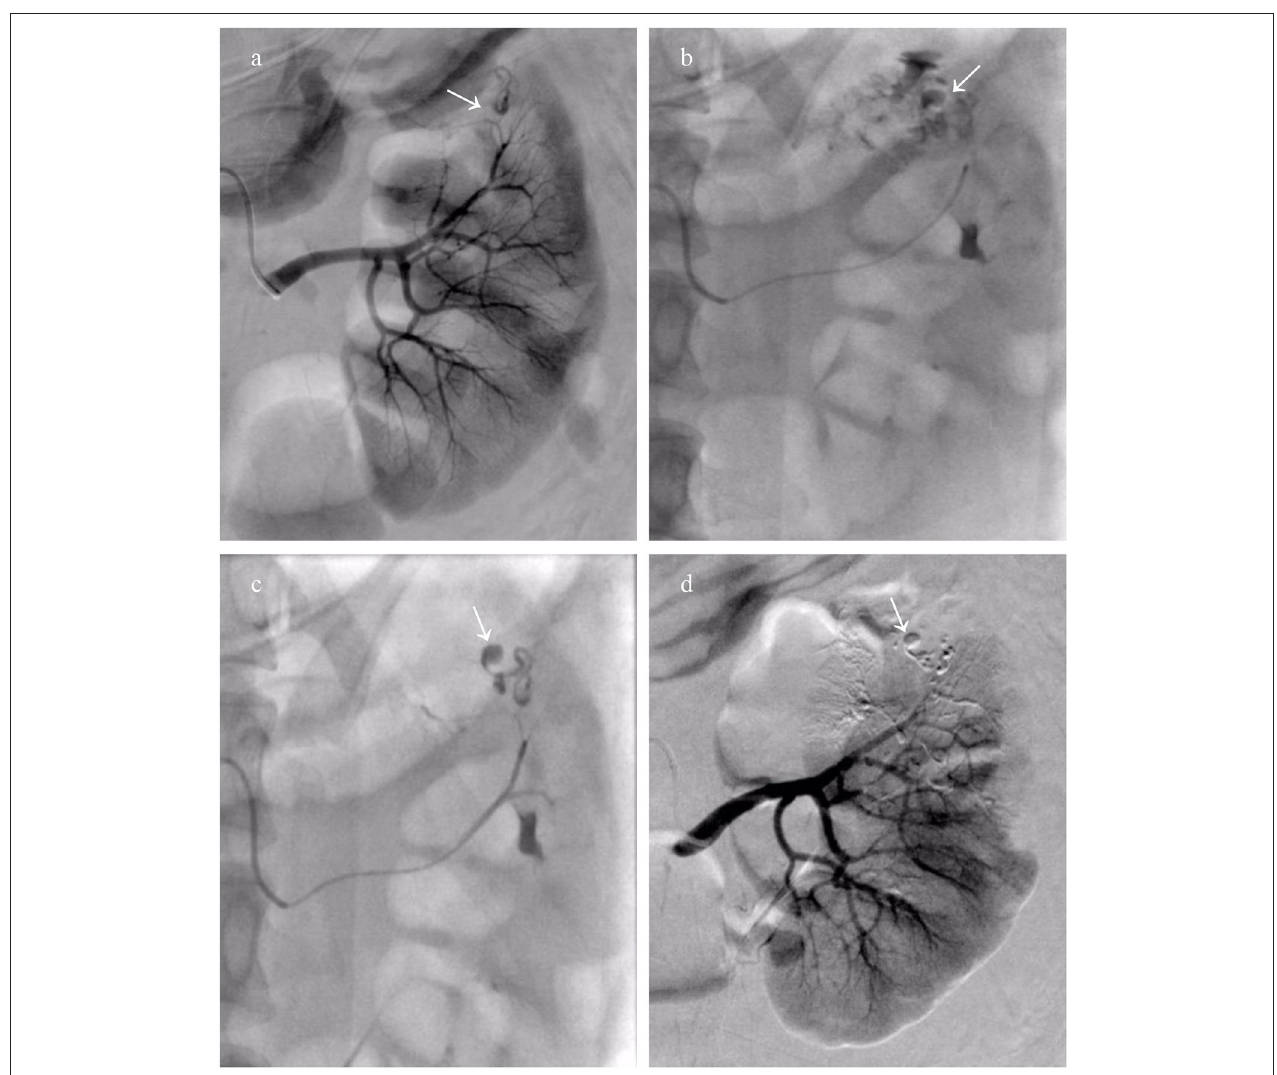
FIGURE 2 | A patient who encountered Wunderlich syndrome (WS) secondary to ruptured renal angiomyolipoma (rAML) underwent transcatheter arterial embolization (TAE) using Glubran 2. (a) The left renal overview arteriography revealed a dysplastic and aneurysmal artery (white arrow); (b) Thumb pressure angiogram through the microcatheter demonstrated rupture of the renal parenchyma and spilling of the contrast agent (white arrow); (c) The mixture of Glubran 2 and ethiodized oil (concentration ratio 1:7) was injected as slowly as possible into the bleeding target arterial, cast filling dysplastic, and aneurysmal arteries (white arrow); (d) Completion arteriography after TAE with Glubran 2 demonstrating AML devascularization and maximum preservation of the normal renal